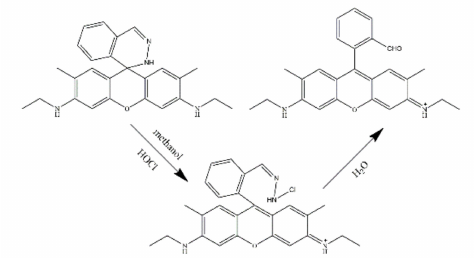
Figure 47. The proposed mechanism of 6G-ClO (Table 3, No. 10) with ClO − [99]. Zhang D., et al. reported a ClO − sensor (SRh) (Table 3, No. 11) synthesized by the conjugation of dual-binding benzene and rhodamine B [100]. SRh showed an “off-on” response to ClO − , visible to the naked eye (Figure 48). The detection limit was calculated to be 2.43 × 10 − 9 M. Wang K., et al. synthesized a turn-on NIR fluorescent sensor with rhodamine derivatives for SO 32 − detection (Table 3, No. 12) [101]. The addition of SO 23 − attacked the 4-position carbonyl group in levulinic acid and induced the ester bond cleavage, resulting in the formation of the fluorophore. The ICT process was then restored, and the sensor showed the corresponding NIR fluorescence (Figure